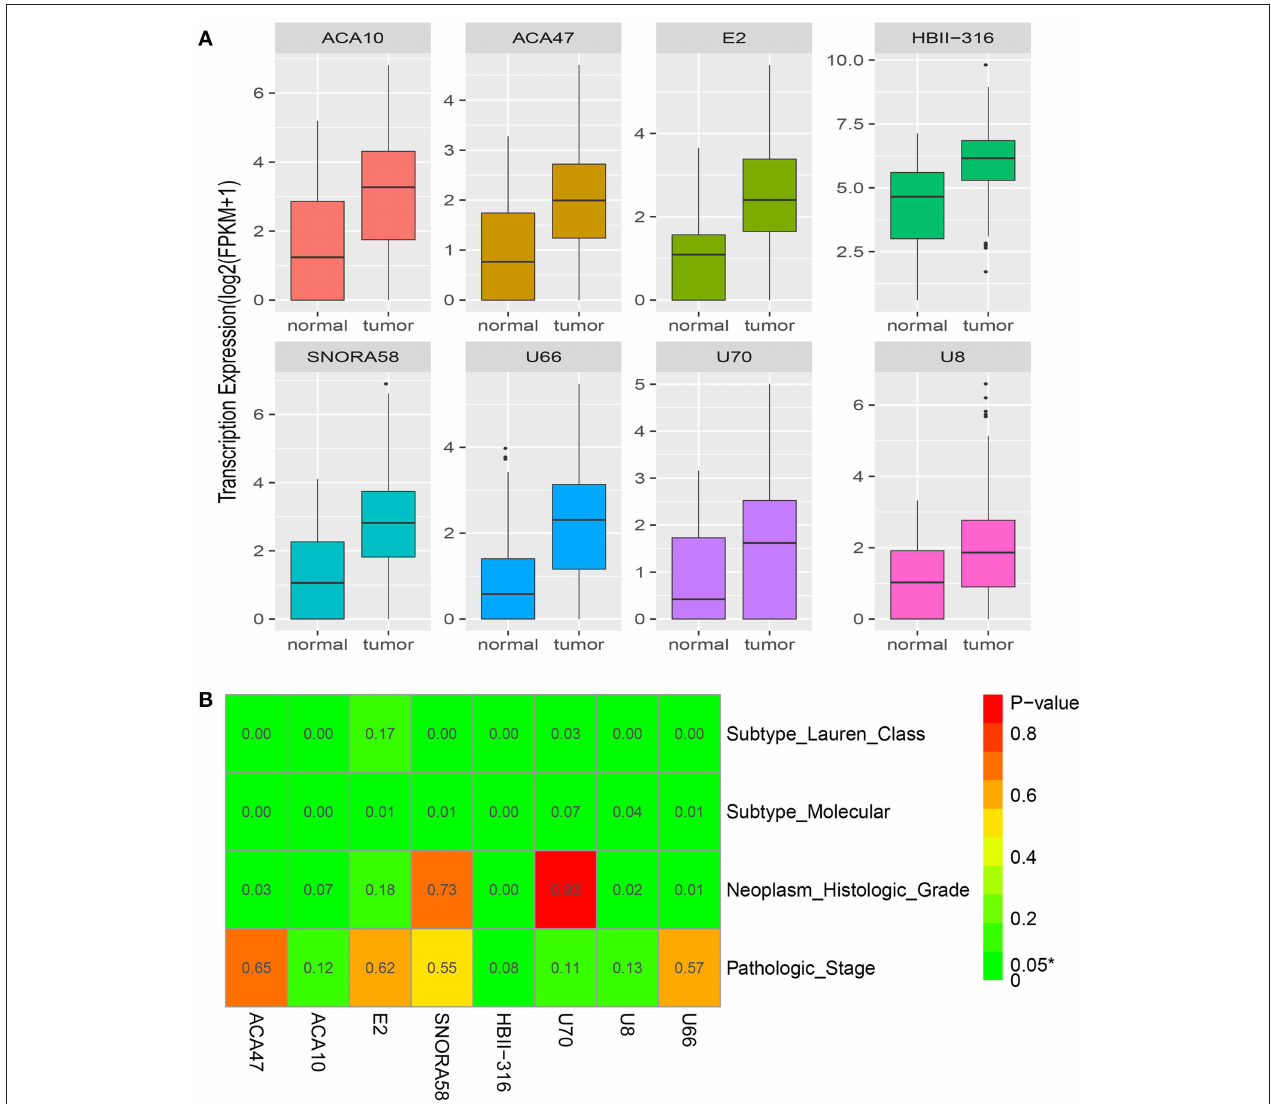
FIGURE 4 | Clinical significance of the eight snoRNAs. (A) The expression profile of eight snoRNAs between normal and tumor tissues. (B) The correlation between clinical features and the eight